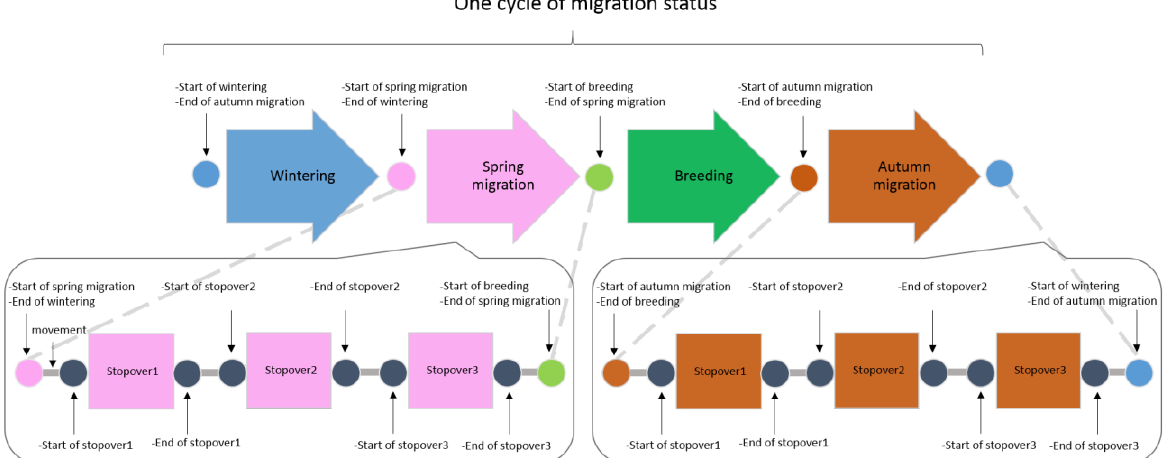
Figure 3. Conceptual diagram for explaining migration status and change